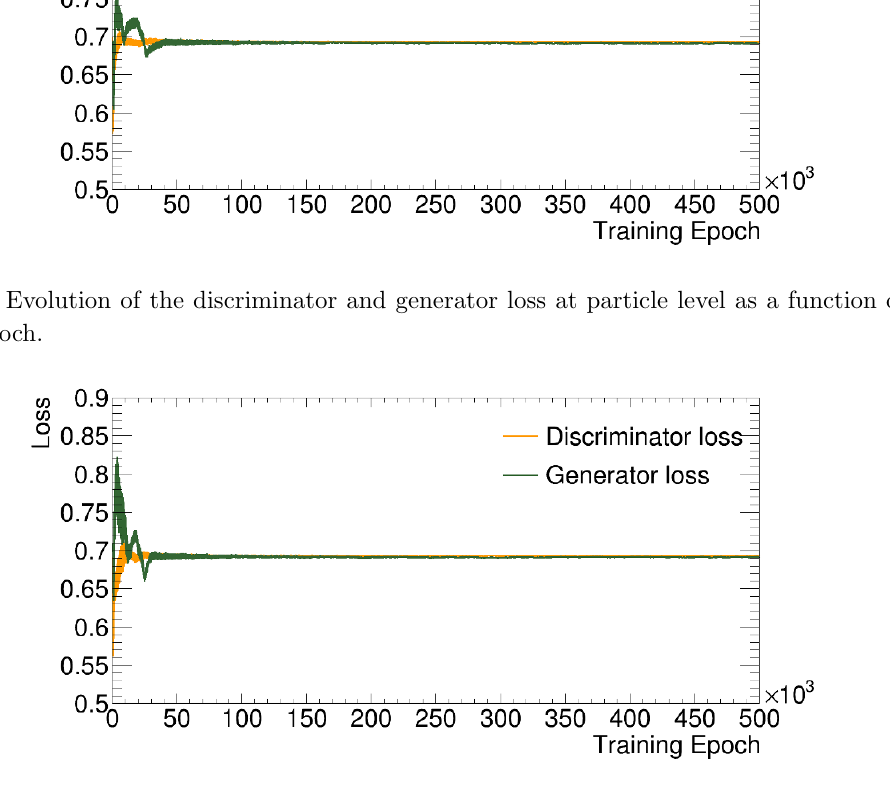
Figure 3 . Evolution of the discriminator and generator loss at reco level as a function of the training